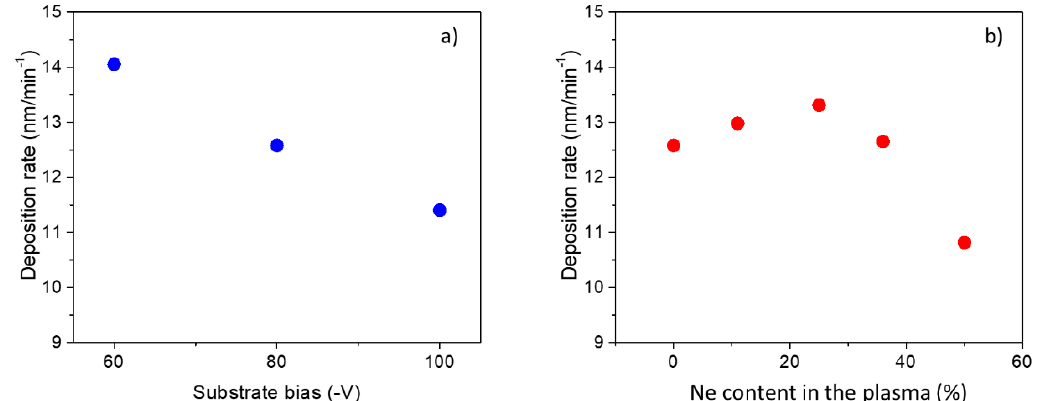
Figure 6. Deposition rate of the DLC films as a function of the substrate bias ( a ) and the Ne content in the plasma ( b ).